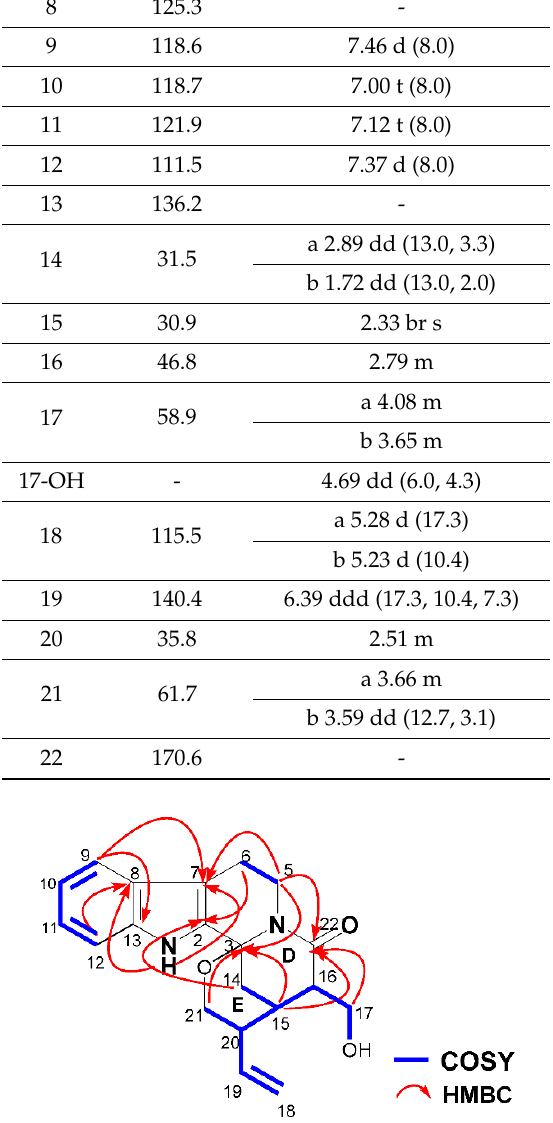
Figure 2. 1 H- 1 H COSY and key HMBC correlations of 1 .